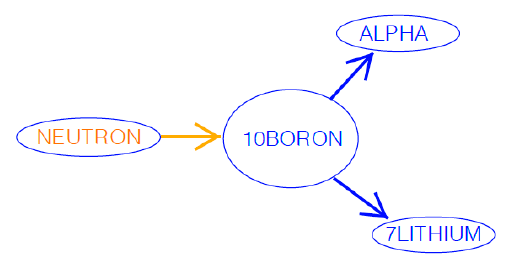
Figure 1. Nuclear bombardment of 10Boron with neutrons, emitting an Alpha particle and a 7Lithium particle.